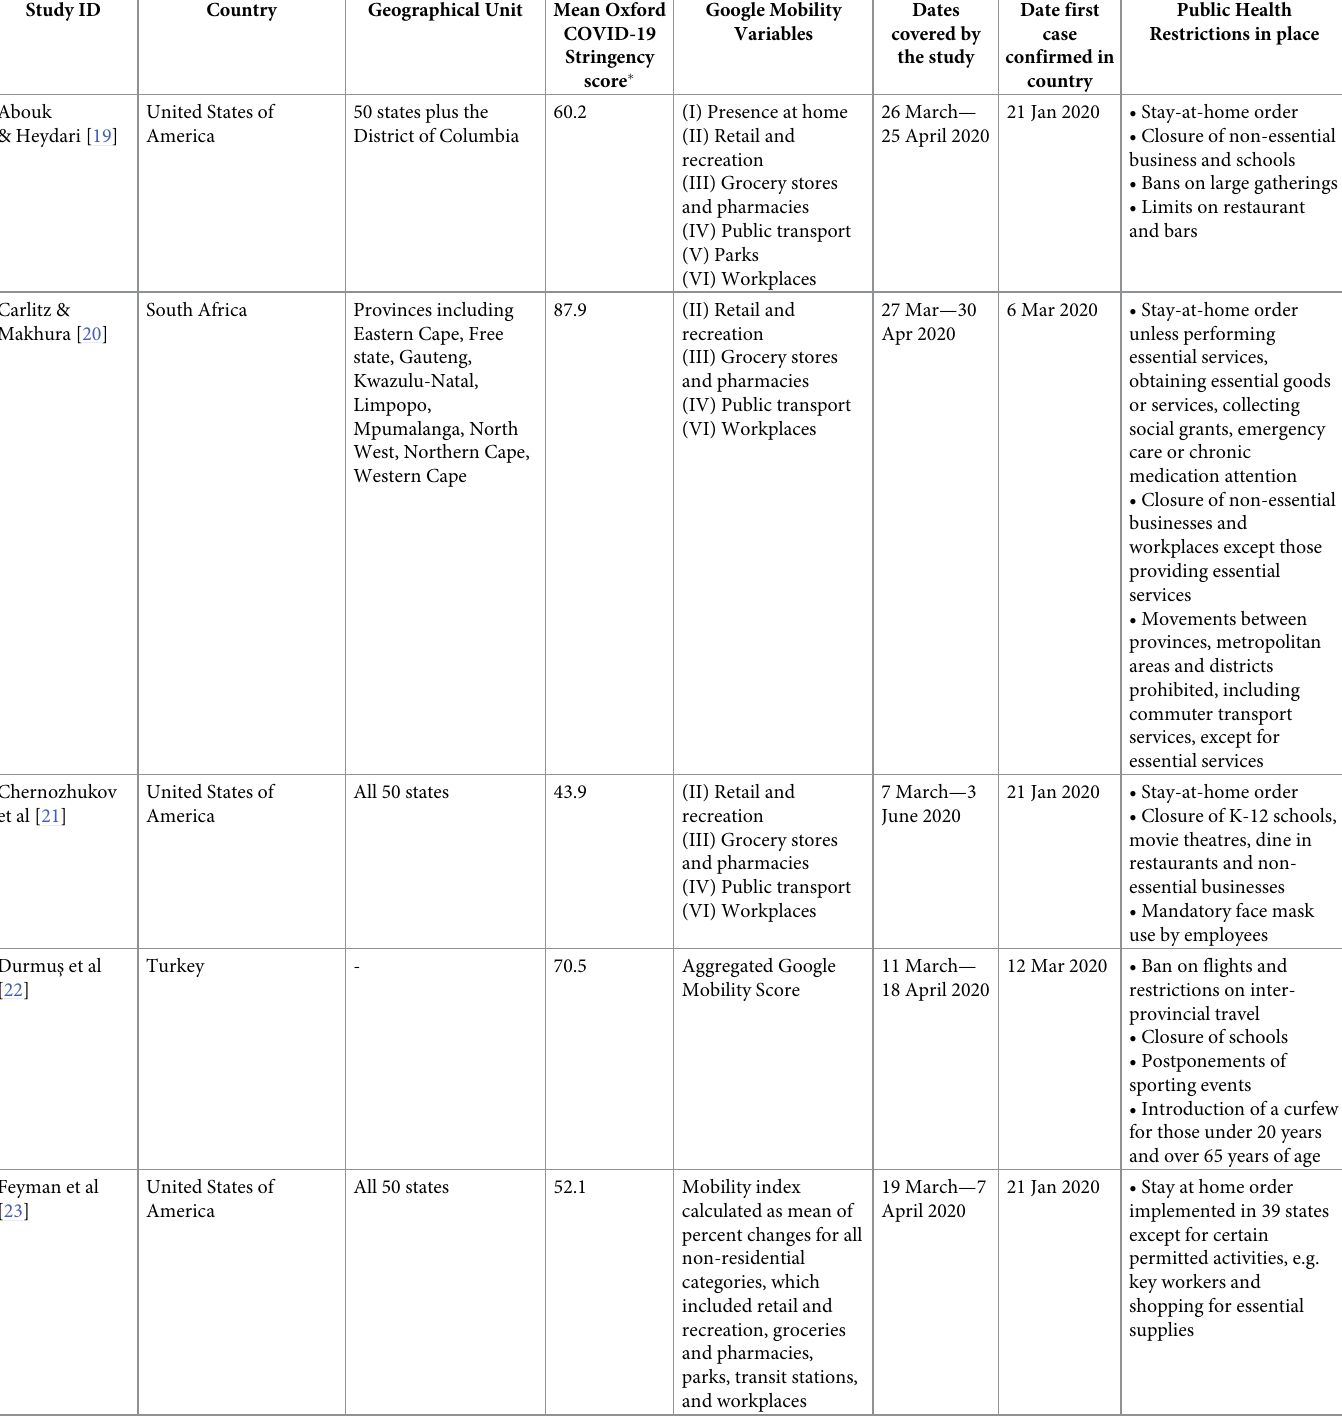
Table 1. Characteristics of included